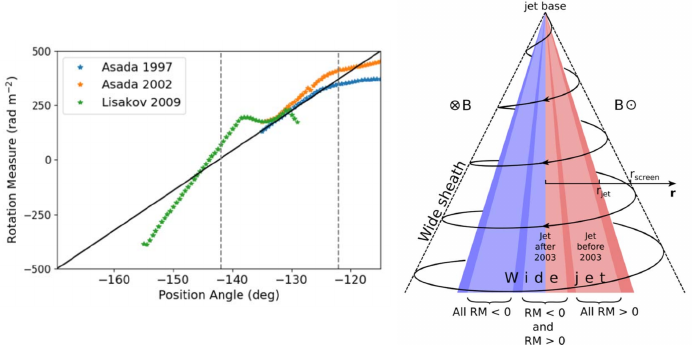
Figure 9. ( Left ) The RMs of the 3C 273 jet as functions of the jet position angle at the projected distance of 9 mas from the core observed in 1997 (blue) and 2002 (orange), reported by Asada et al. [143], and in 2009 reported by Lisakov et al. [146]. The two vertical dashed lines represent the average jet position angle before (at − 122 ◦ ) and after (at − 142 ◦ ) the major jet swing occurred in 2003. The black solid line denotes a linear fit to all data points. ( Right ) Illustration of the jet-sheath model developed by Lisakov et al. [146] to explain the observed RM data. The jet illuminates different parts of the sheath that is threaded by a helical magnetic field in different epochs, resulting in the change in the transverse RM gradients. ©AAS. Reproduced with